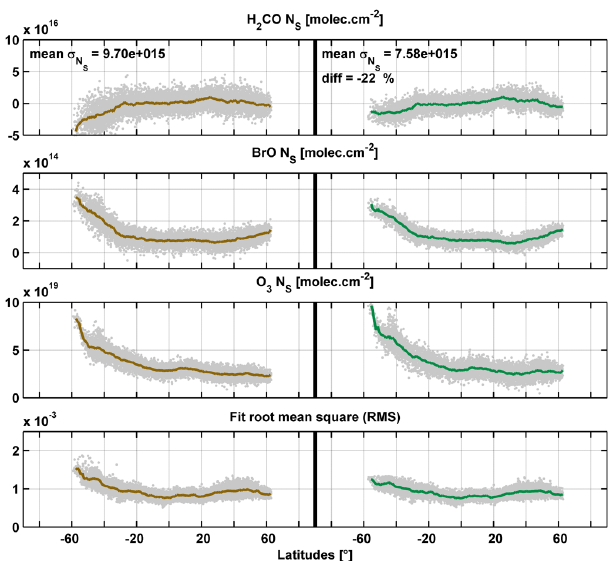
Fig. 5. H 2 CO, BrO and O 3 slant columns, and root mean square of the DOAS fit for one GOME-2 orbit (13 August 2007, orbit number 4227). The left column corresponds to the initial retrieval settings (v07), while the right column shows the effect of the BrO and O 3 corrections (v12).